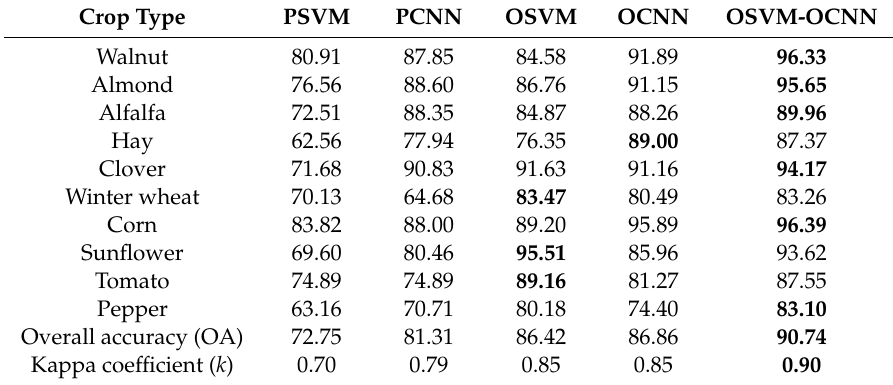
Table 3. Overall accuracy as well as per-class accuracy achieved by the PSVM, PCNN, OSVM, OCNN and OSVM-OCNN method with the UAVSAR image in S1; the greatest classification accuracy per row is highlighted in bold font.